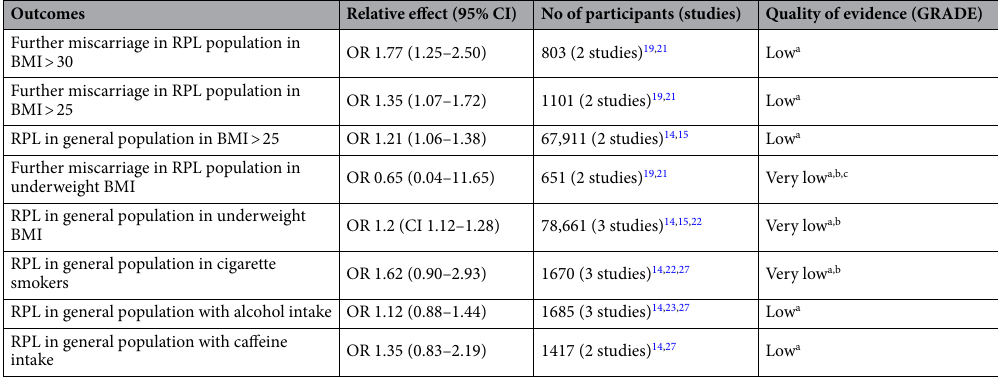
Table 1. GRADE analysis of the evidence used in the meta-analyses. a All observational studies. b Wide variation in the effect estimates across studies. c Number of events too low in study group to detect precise estimate of